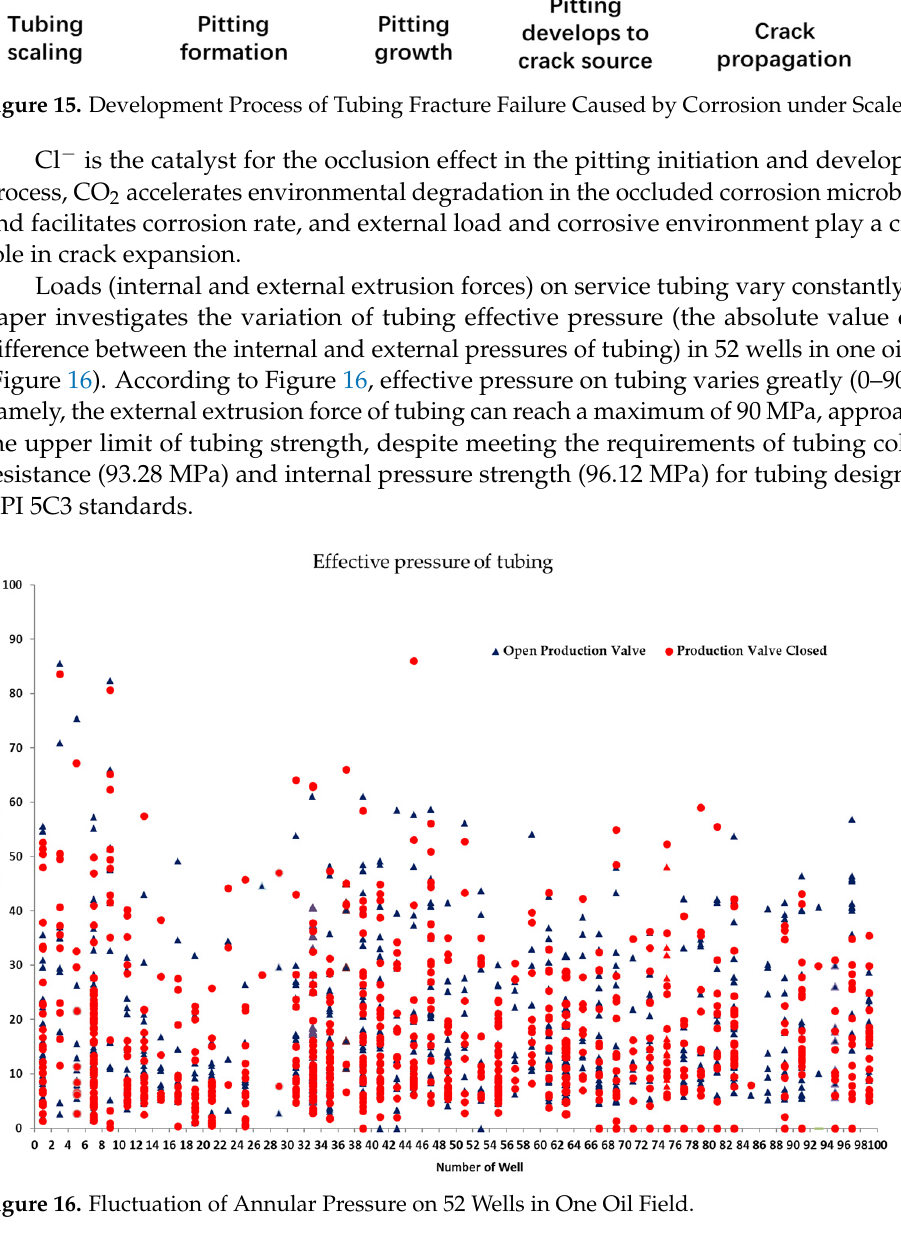
Figure 15. Development Process of Tubing Fracture Failure Caused by Corrosion under Scale.